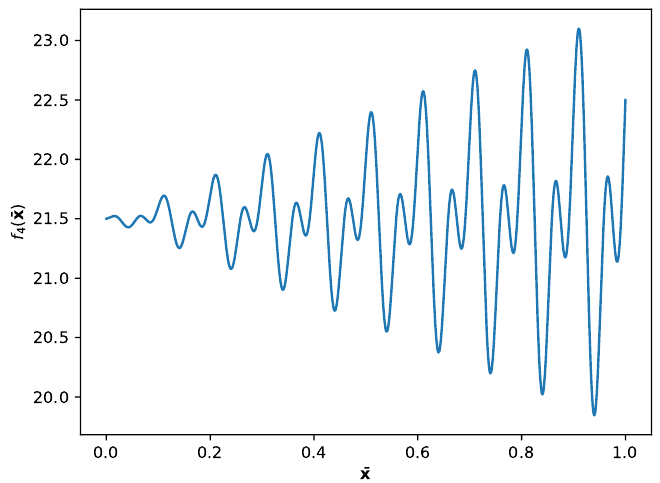
Figure 16. Chart showing values of f 4 ( ¯x ) , with x from 0.8 to